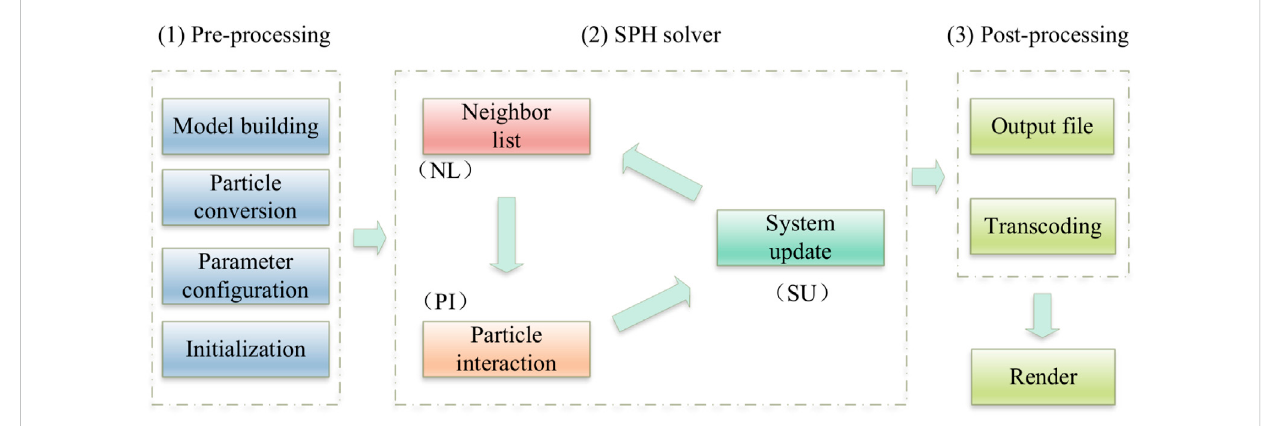
FIGURE 2 In DualSPHysics, pre-processing, SPH solver and post-processing are the three main functional modules of the